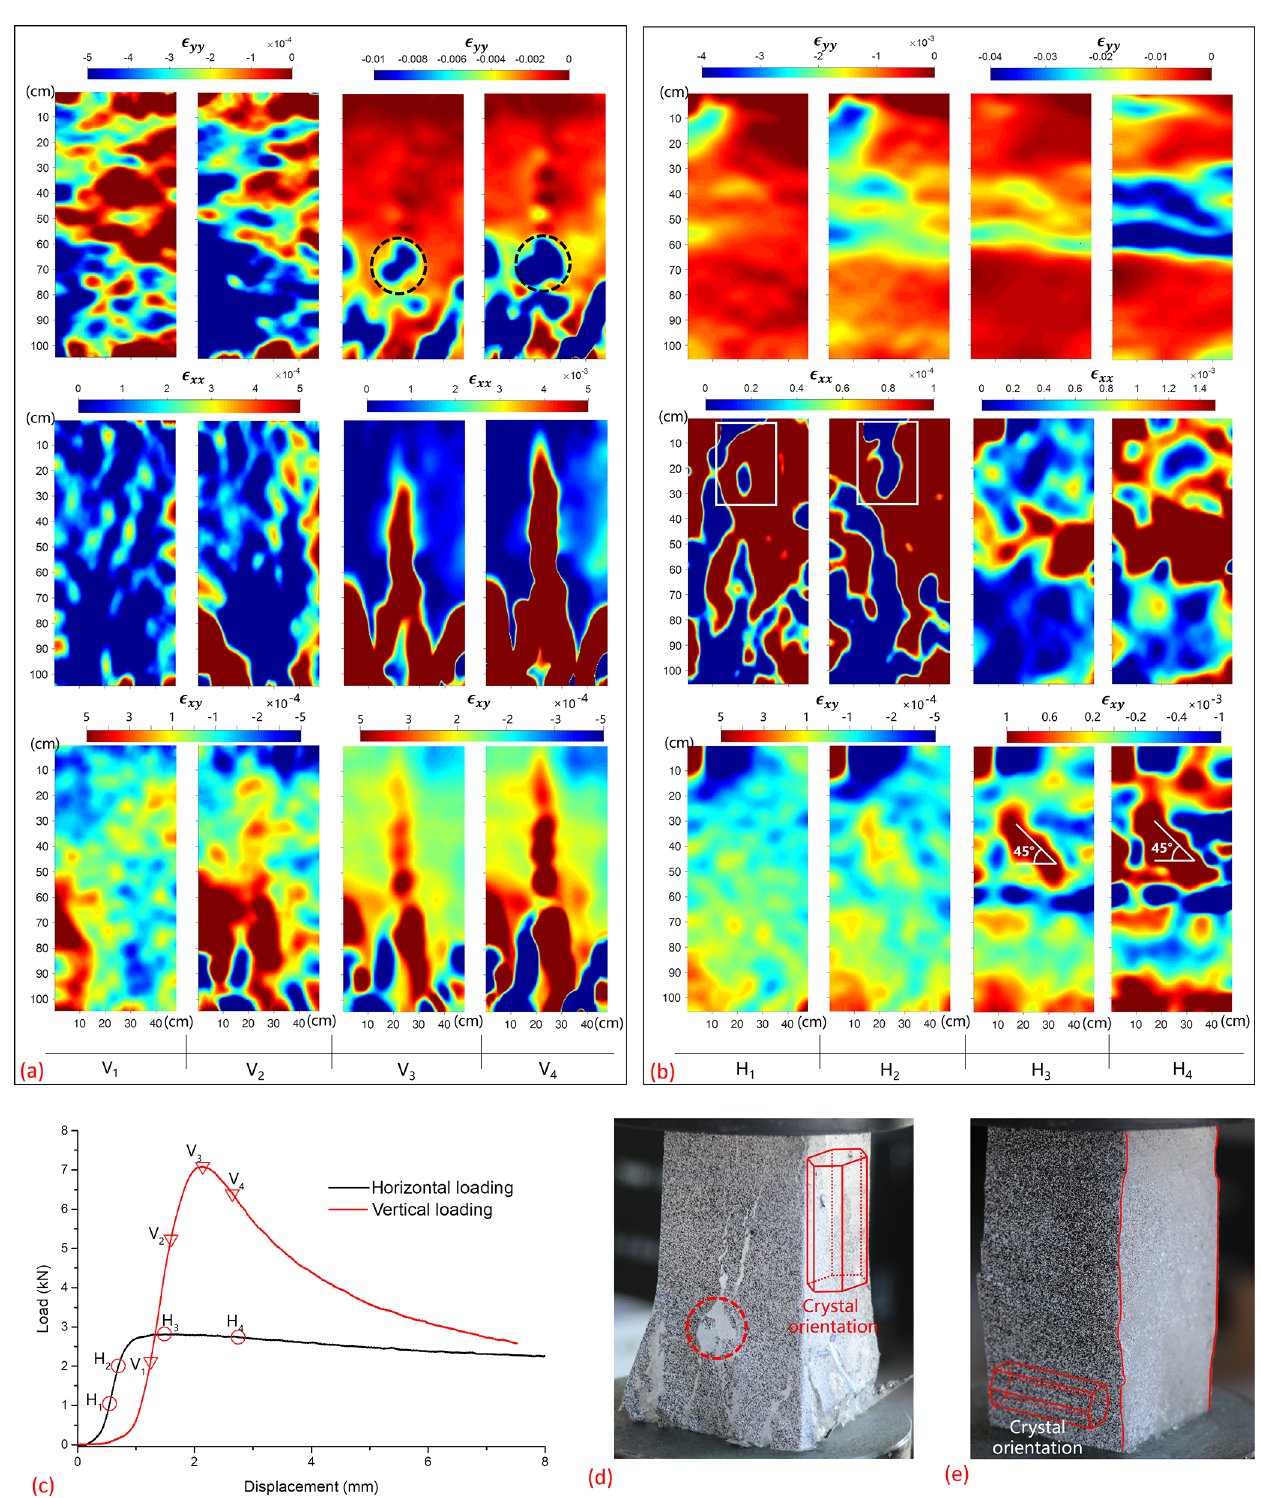
Figure 3. The evolution of strain fields in the uniaxial compression experiment. The strain fields of specimens (a, b) with respect to the vertical and horizontal loading; the x direction and the y direction strain fields and shear strain fields are located from the first to the third row. The columns of V i and H i ( i = 1 ,..., 4) correspond to the time points labeled in the displacement–load curves in panel (c) . The failure pictures (d, e) for the specimens (a, b) . Note that the same color bar is shared by the two neighboring strain fields in panels (a) and (b) to enhance the color